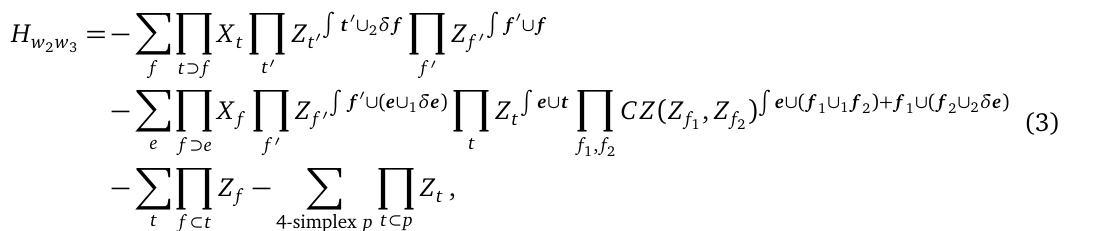
(cid:198) Z = Z Z Z Z f f e 1 e 2 e 3 e 4